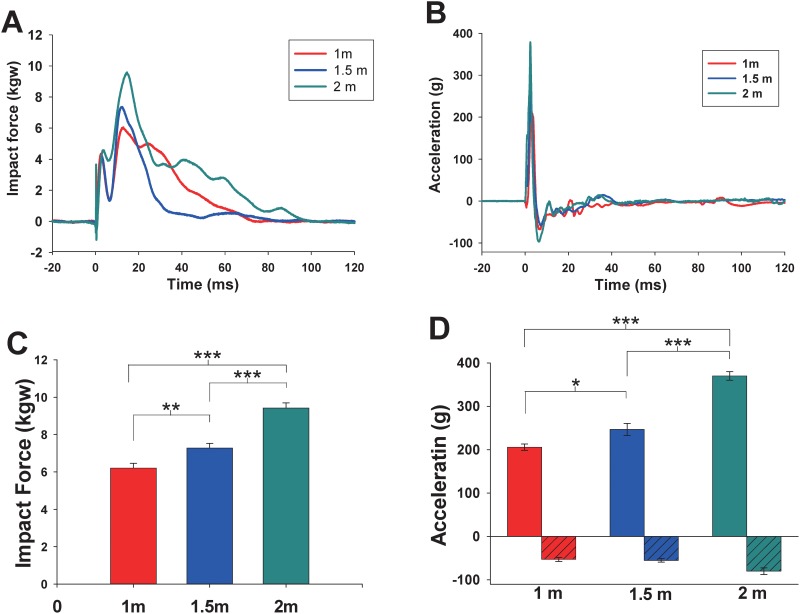
Representative trace of impact force (a) and acceleration (b) during impact from 1-, 1.5-, and 2-m drop tests. Average peak impact force (c) and acceleration (d) from 1-, 1.5-, and 2-m drop tests. The positive bars represent peak acceleration response at the first impact, and negative bars represent rebound deceleration. *p < 0.05; **p < 0.01; ***p < 0.001 per group pair comparison by using the post hoc LSD test. Data are expressed as the mean ± SEM.